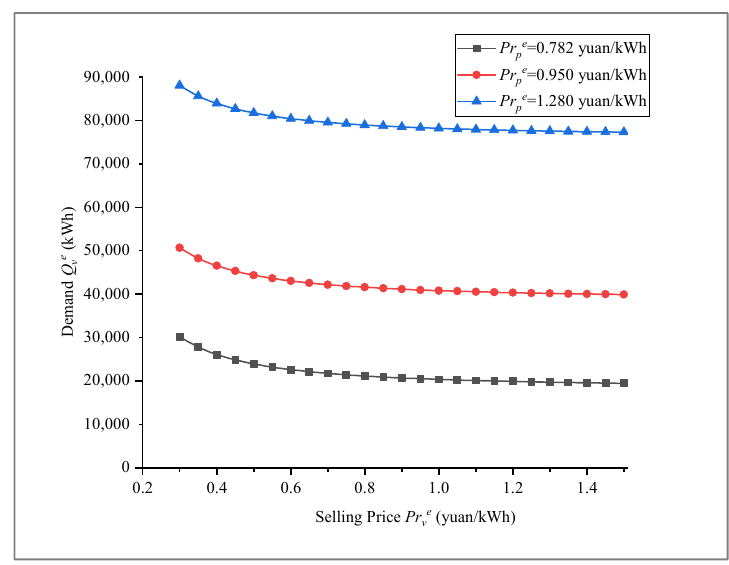
Figure 3. Effect of the change in the valley and peak selling price on the electricity demand.